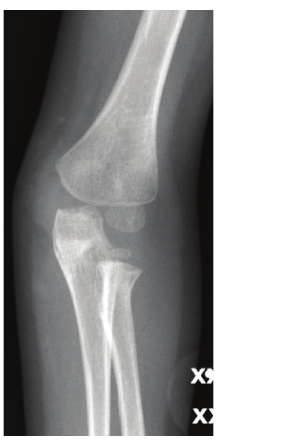
Figure 6: Anteroposterior radiograph four months postoperatively. Note the union of the olecranon fracture and the satisfactory position of the radiocapitellar